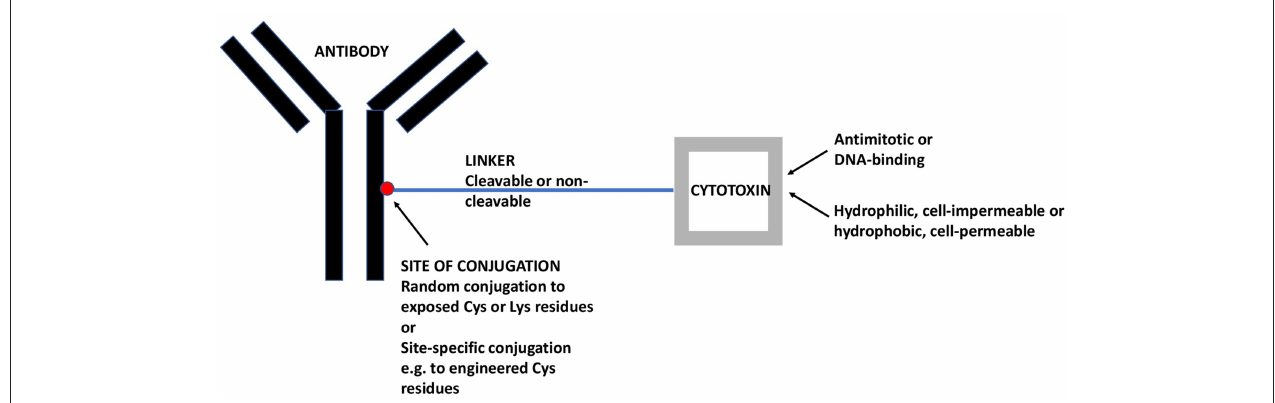
FIGURE 1 | A Schematic View of ADCs and its Individual Components. The mAb targets a tumor-associated antigen, in the present case an antigen that is preferentially expressed on CSCs. The linker may be cleavable (e.g., acid-sensitive or dipeptide) or non-cleavable (e.g., maleimidocaproyl). The cytotoxin may be an antimitotic drug, active only on proliferating cells or a DNA-binding drug, active also on quiescent cells. Moreover, the cytotoxin may be hydrophilic and act only within the internalizing cell or it may be hydrophobic and act also on nearby cells, whether antigen-positive or –negative (so-called bystander effect). ADC, antibody-drug conjugate; CSC, cancer stem-like cell; mAb, monoclonal antibody.